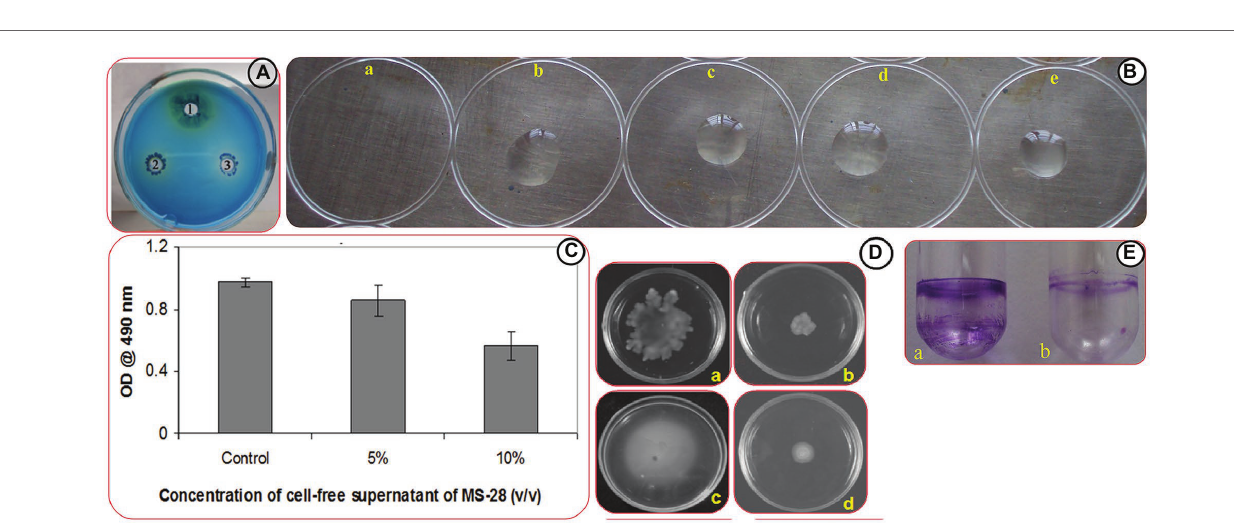
FIGURE 2 | Effect of Psychrobacter sp. on virulence factors production in PAO1. (A) Rhamnolipd production in PAO1. Image represents rhamnolipid production in untreated control (1), and PAO1 treated with CFS of Psychrobacter sp. at of 100 (2) and 200 μ l/ml (3) Concentrations. (B) Assessment of biosurfactant production through drop collapse assay. Images represent the activity of untreated PAO1 (a) , and PAO1 treated with CFS of Psychrobacter sp. at concentrations of 50–200 μ l/ ml (b-e) . (C) Quantitative analysis of EPS inhibition in PAO1 cells treated with and without Psychrobacter sp. CFS. Data represent the OD values of the EPS. Mean values represent the data of three independent experiments and SD are shown. (D) Effect of Psychrobacter sp. on the motility of PAO1. Swimming and swarming motilities of untreated control of PAO1 (a,c) and PAO1 treated with Psychrobacter sp. CFS (200 μ g/ml; b,d ), respectively. (E) Analysis of PAO1 biofilm formation in the absence (a) and presence (b) of Psychrobacter sp. through ring assay.